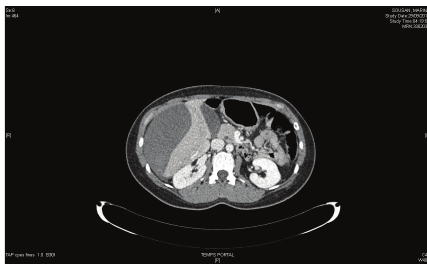
Figure 2: Abdominal CT scan with subcapsular hematoma and active bleeding.